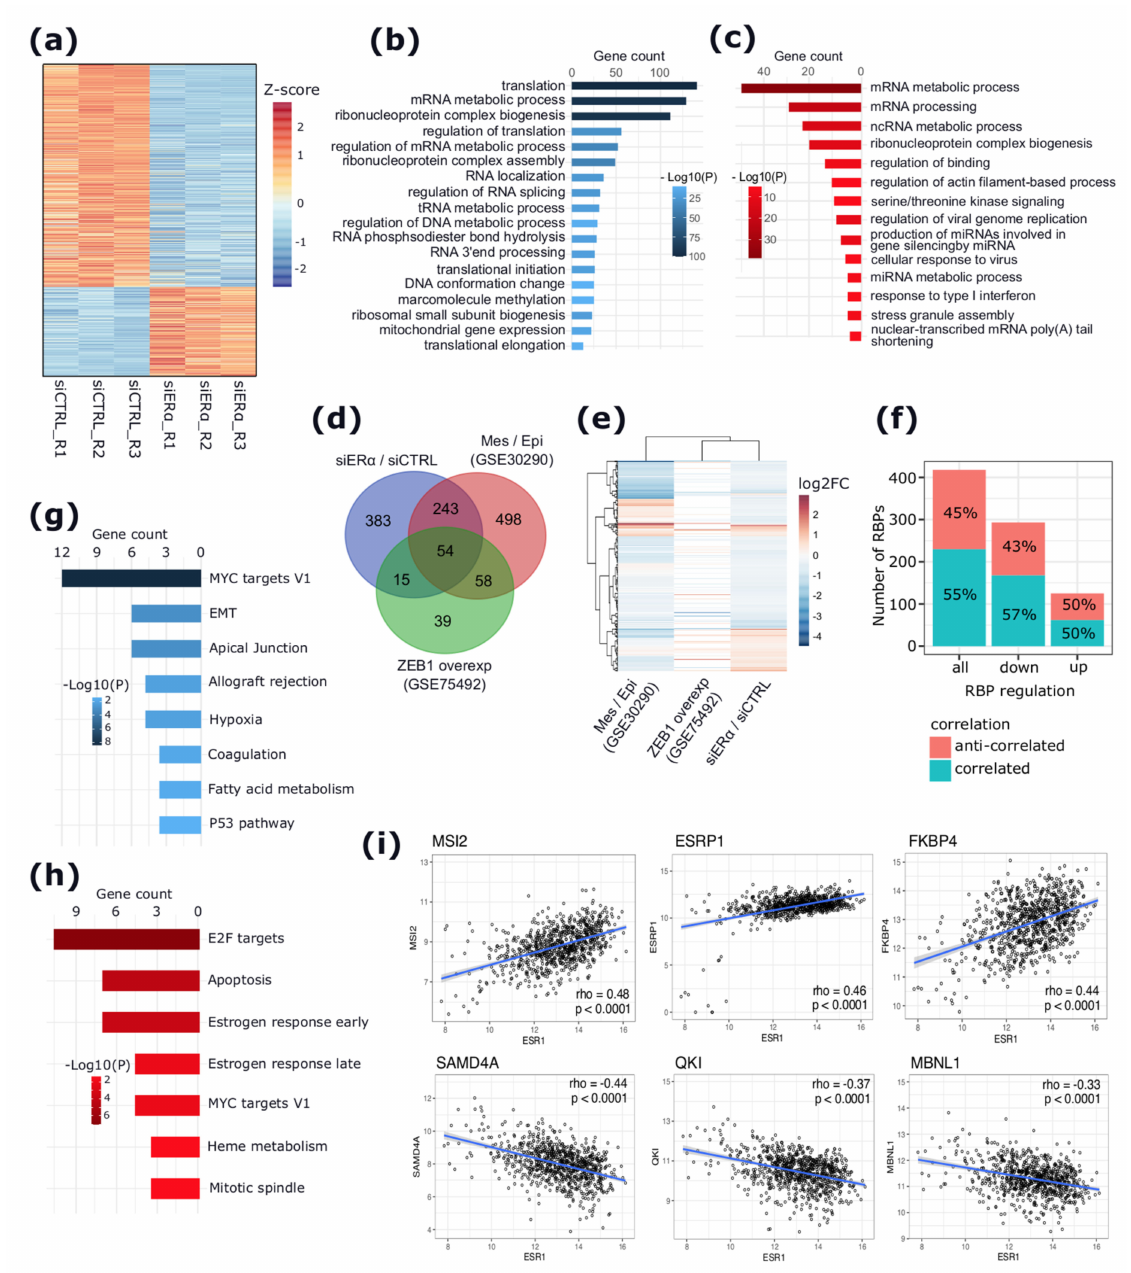
Figure 1. RBPs gene expression changes induced by apoER α in MCF-7 cells and their correlation with ER α mRNA levels in primary tumors. ( a ) Heat map reporting the expression levels of RBPs in siCTRL and siER α conditions ranked by z-score. ( b , c ) Bar plots representing significantly enriched processes related to apoER α -induced ( b ) and apoER α -repressed RBPs ( c ) , respectively. ( d ) Venn diagram showing the overlap between regulated RBPs in this study and those in GSE30290 and GSE75492 datasets. ( e ) Heat map showing the log2FC of overlapping RBPs between the three studies in ( d ). Missing RBPs from each study are reported in white color. ( f ) Stacked bar plot reporting the number of RBPs positively or negatively correlated with ER α mRNA levels in primary tumors (y-axis) and their regulation by apoER α activity depletion in MCF-7 cells (x-axis). ( g , h ) Bar plots reporting enriched gene sets hallmarks related to RBPs that are anti-correlated ( g ) and correlated ( h ) with ER α mRNA levels in primary tumors, respectively. ( i ) Scatter plots reporting six selected RBPs showing significant correlations with ER α mRNA levels in primary